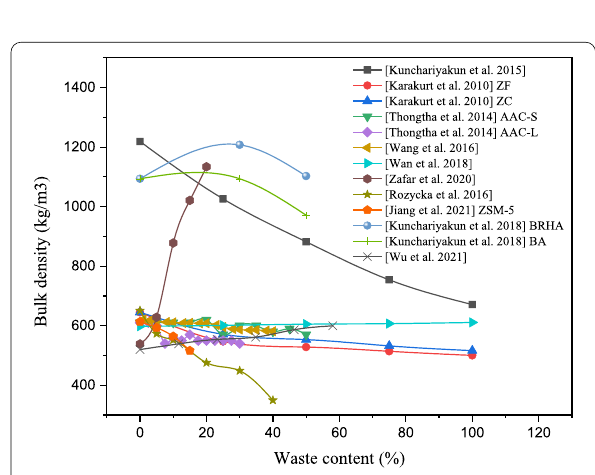
Fig. 7 Bulk density of AAC on the addition of various